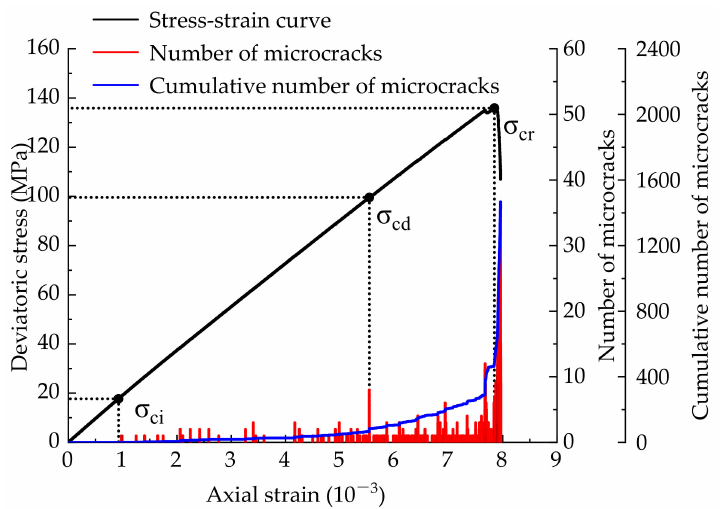
Figure 8. Relationship between deviatoric stress, number of microcracks, cumulative number of microcracks and axial strain.